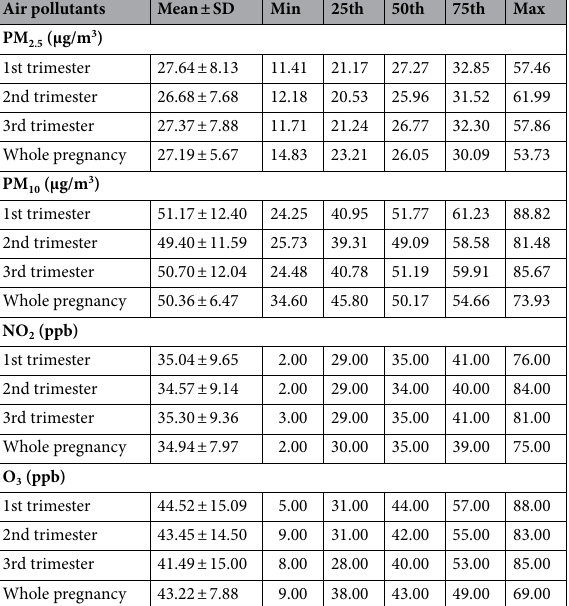
with PSS were greater for nulliparous women and women with low incomes, but p-values for interaction terms were not significant (p > 0.05).